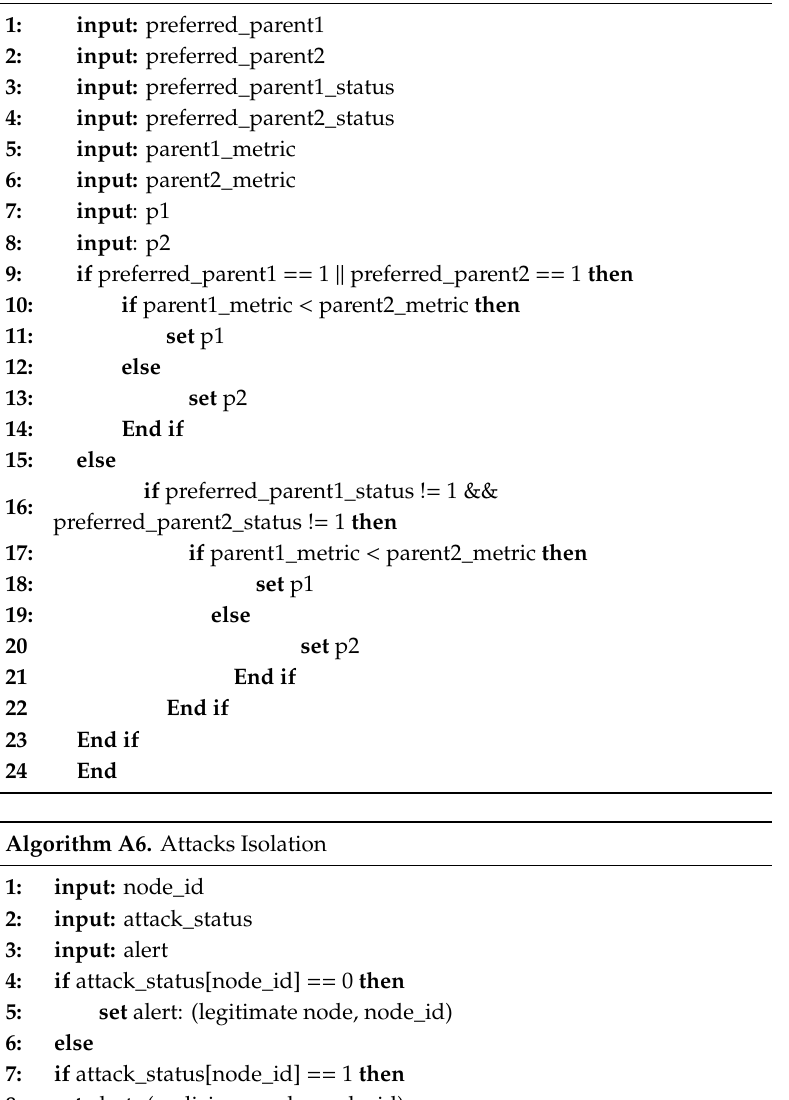
Algorithm A5. Rank Attack Mitigation